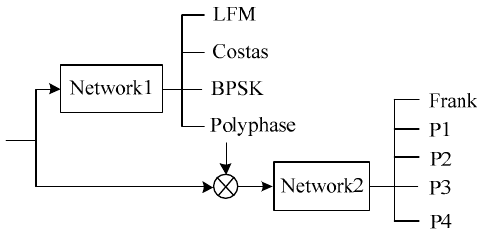
Table 1. The phase of 8 radar waveforms.